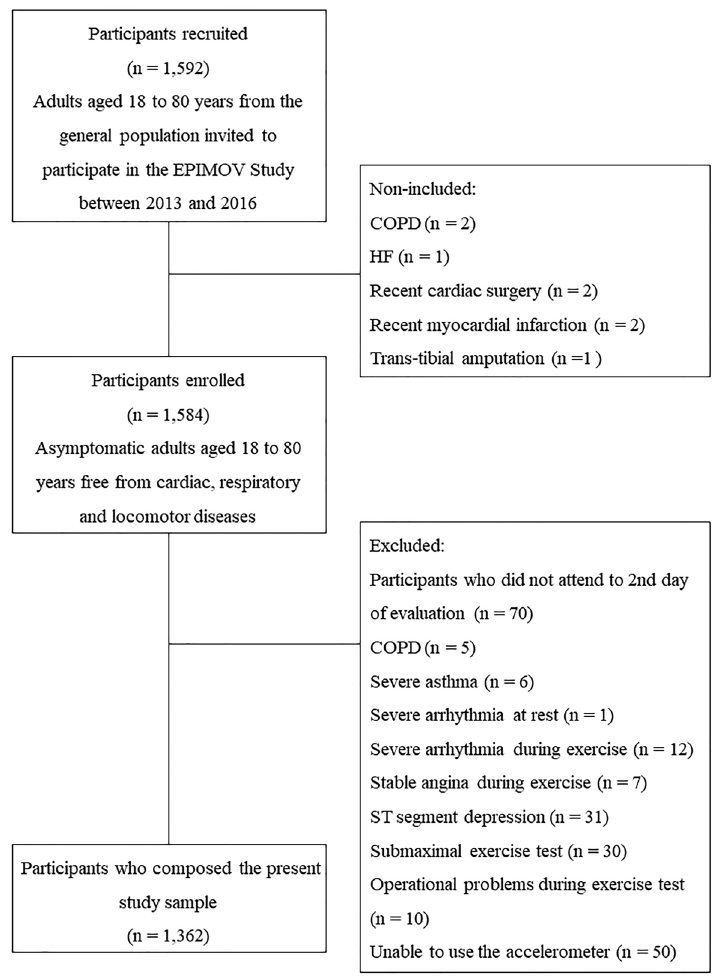
Figure 1. Flowchart of the study. COPD: chronic obstructive pulmonary disease; HF: heart failure; EPIMOV: Epidemiology and Human Movement